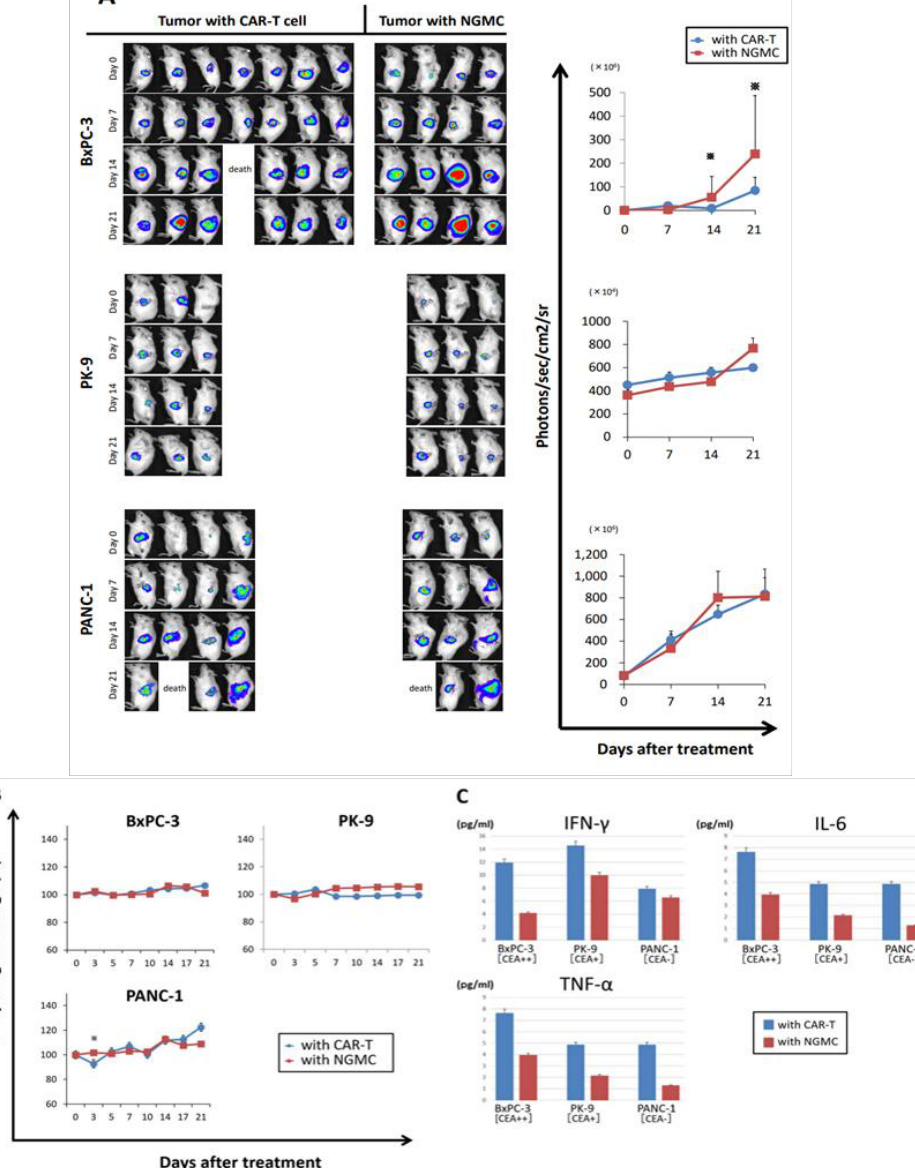
Figure 5. Suppression of transplanted pancreatic carcinoma upon adoptive therapy with anti-CEA- CAR-T. ( A ) Orthotopic PDAC mouse models were prepared by intrapancreatic injection of CEA − (PANC-1), CEA + (PK-9) or CEA ++ (BxPC-3) pancreatic carcinoma cell lines (1 × 10 6 cells/mouse) in NOG mice, each type of cells was marked with luciferase for bioluminescence imaging. When tumors were established, anti-CEA-CAR-T was injected into the tail vein at day 0 (2.5 × 10 6 cells/mouse). For comparison, T cells without CAR were injected. Tumor growth was monitored once a week using IVIS imaging. The enhancement of tumor luciferase signal was significantly decreased in only the BxPC-3 model on days 14 and 21. ( B ) Changes in weight over time. There were no significant weight changes in all groups. ( C ) Serum levels of cytokines in mice were measured. Pooled serum samples from mice were collected on day 21 and subjected to analysis by cytokine beads arrays. Although cytokine release tended to be higher in the CAR-T group in all models, there were no significant difference of changes in serum levels of cytokines between the CAR-T and NGMC groups.